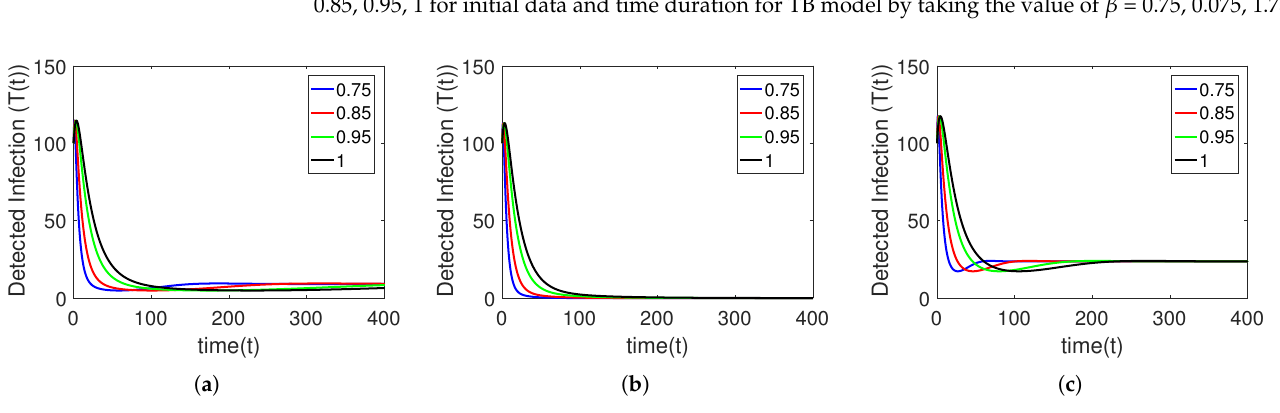
Figure 15. Graphical view ( a – c ) of the Detected infected class on different arbitrary orders γ = 0.75, 0.85, 0.95, 1 for initial data and time duration for TB model by taking the value of β = 0.75, 0.075,